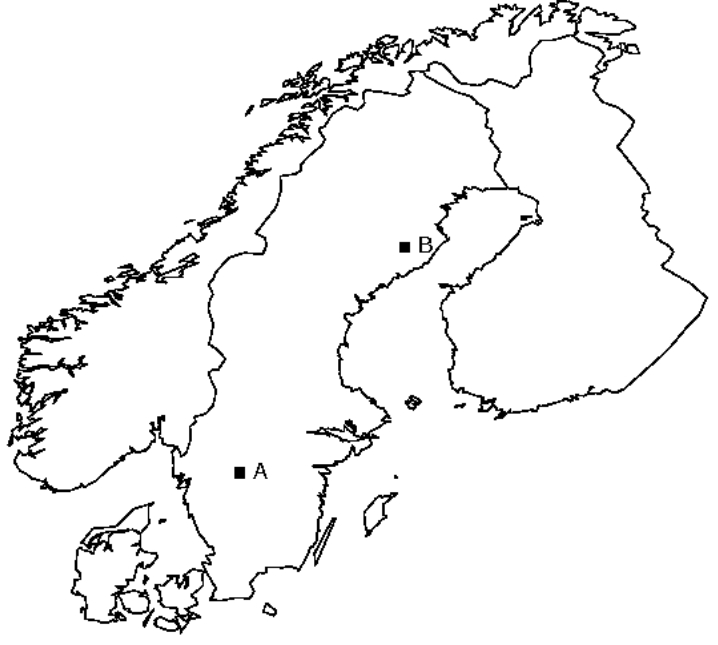
Figure 1. Location of the test sites in Sweden. A: Remningstorp test site; B: Svartberget test